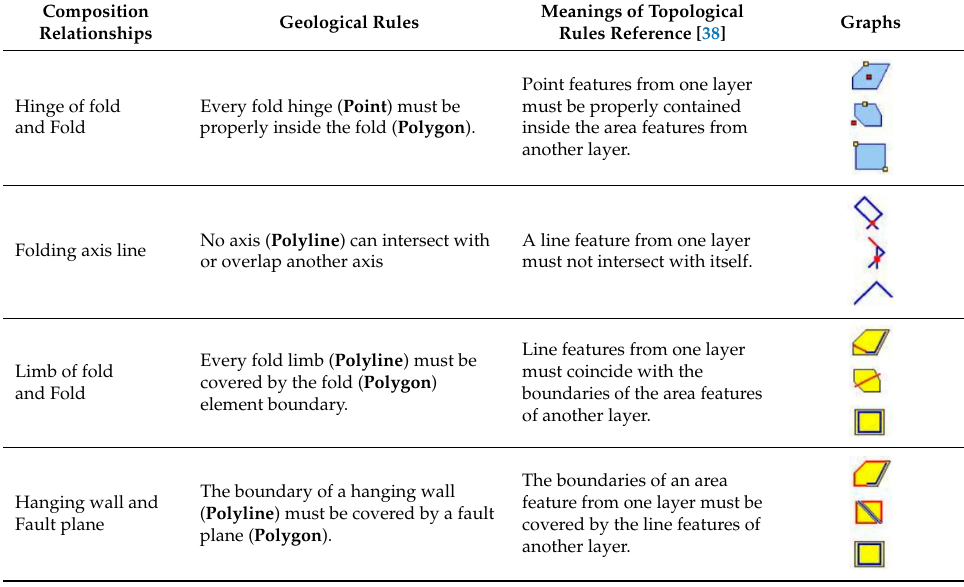
Table 4. Corresponding topological descriptions in the composition relationships. Meanings of Topological Rules Geological Rules Reference [38]